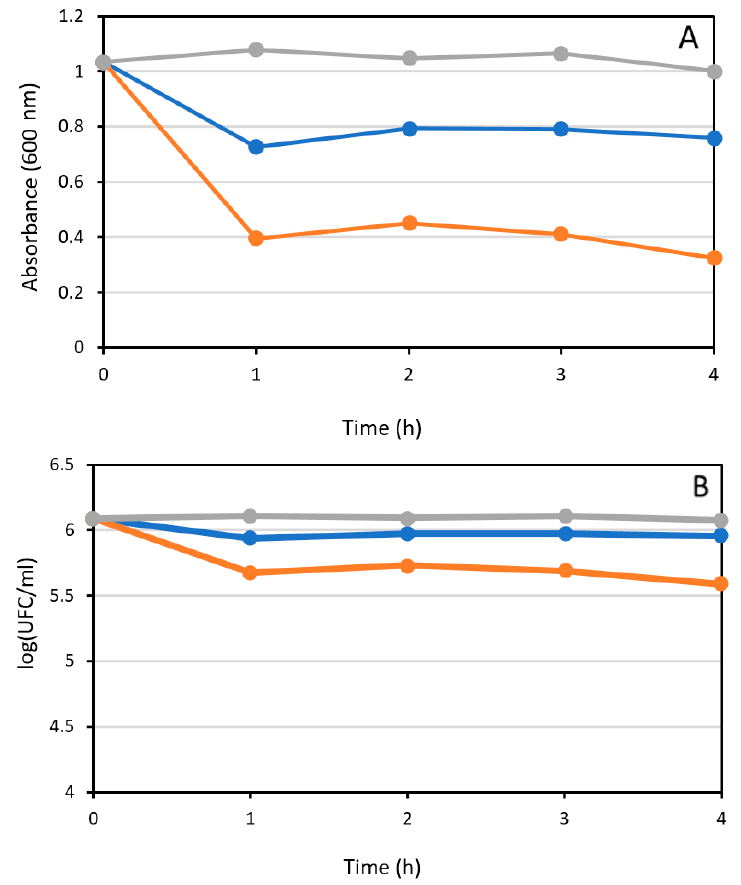
Figure 11. Adsorption kinetics of Salmonella on sepiolite and sep-PCH measured in absorbance ( A ) and concentration ( B ). The three treatments are: control (grey line), sepiolite (blue line) and sepiolite-PCH (orange line).